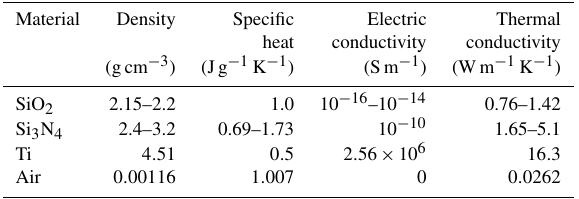
Table 1. A summary of the most important material properties that are used in the manufacturing of the test devices.